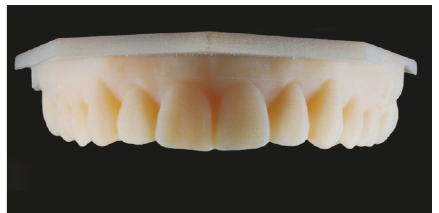
Figure 4: 3D resin model obtained from the wax-up scanning.